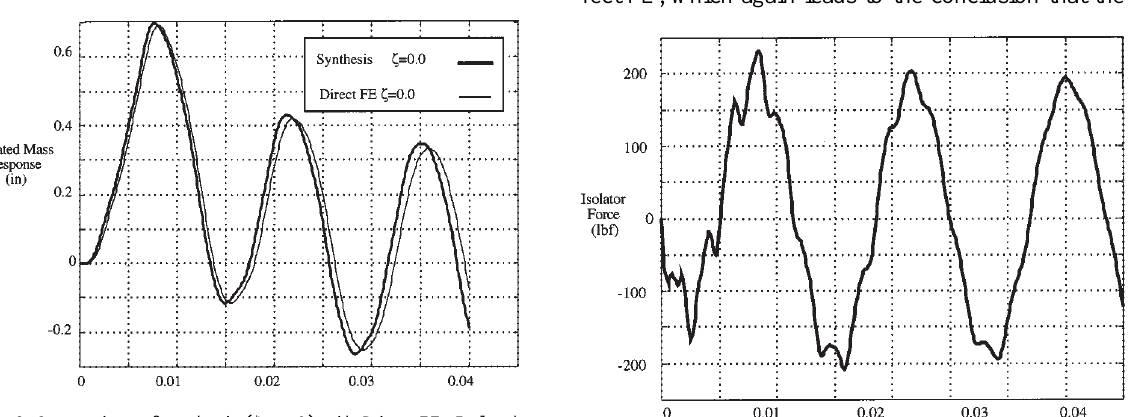
Fig. 5. Comparison of synthesis ( (cid:16) = 0) with Direct FE: Plate corner (at isolator) vertical response vs time.